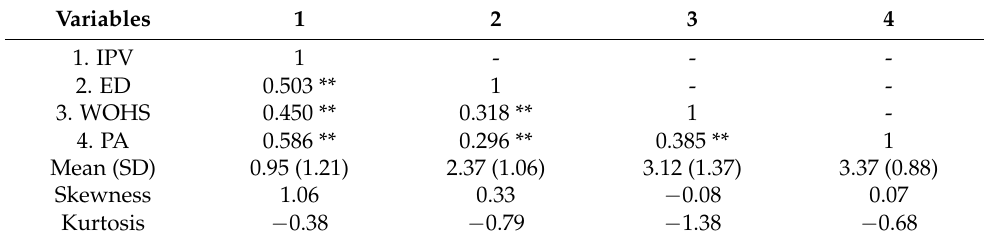
Table 2. Distribution, normality estimates, and correlation matrix for all variables.